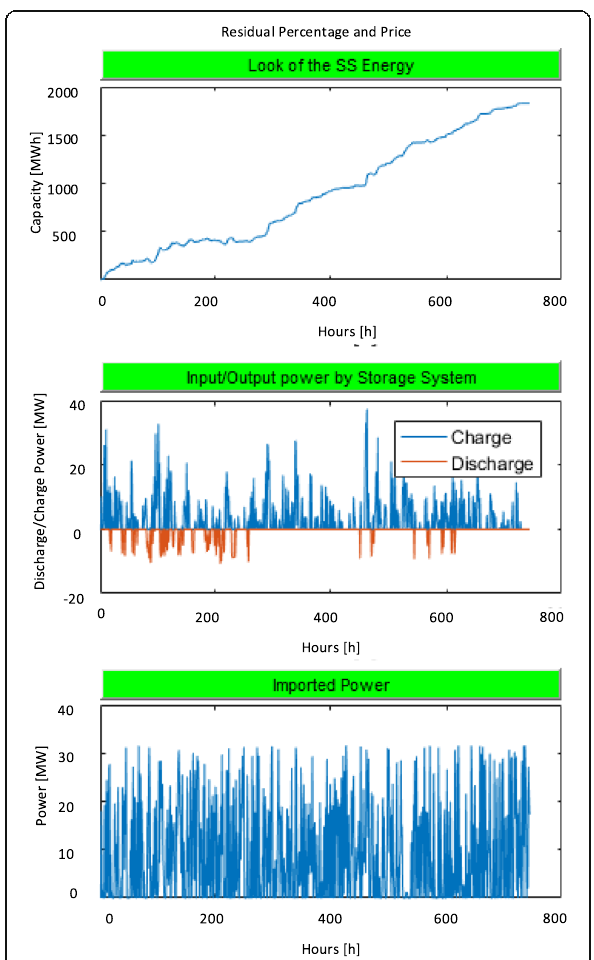
Fig. 4 Sizing ESS with Surplus Power and Price Method (number of RES optimal for Surplus Power Method)